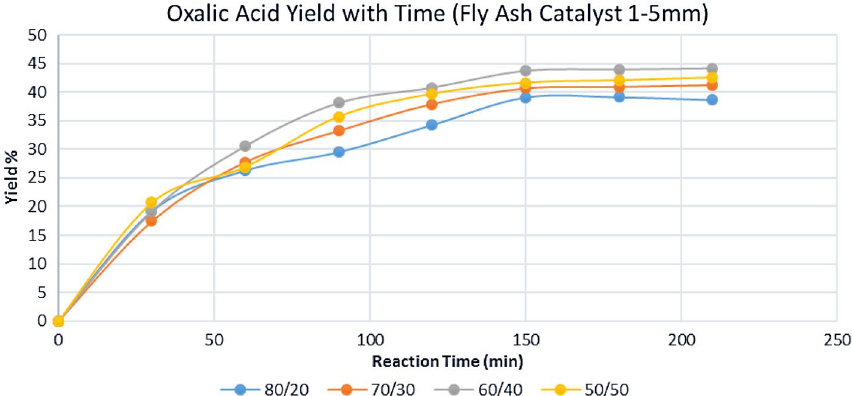
Fig. 4 Yield of oxalic acid using coarse fly